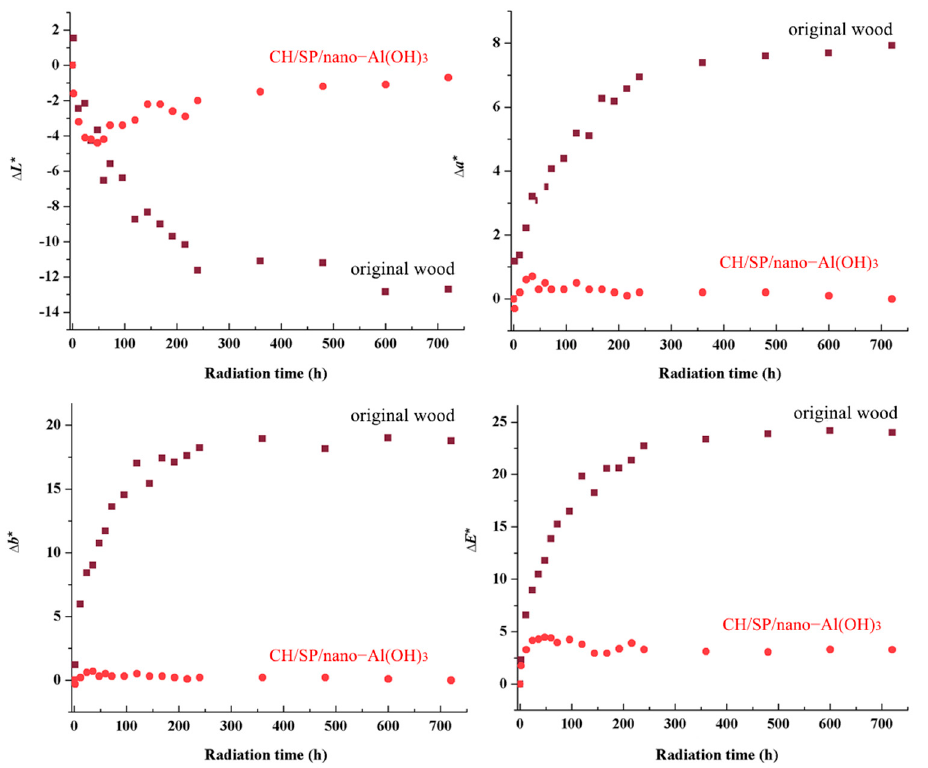
Figure 3. Changing parameters ∆ L *, ∆ a *, ∆ b *, and ∆ E* of the original wood and the Figure 3 . Changing parameters Δ L* , Δ a* , Δ b* , and Δ E* of the original wood and the CH/SP/Al(OH) 3 CH/SP/Al(OH) 3 wood.